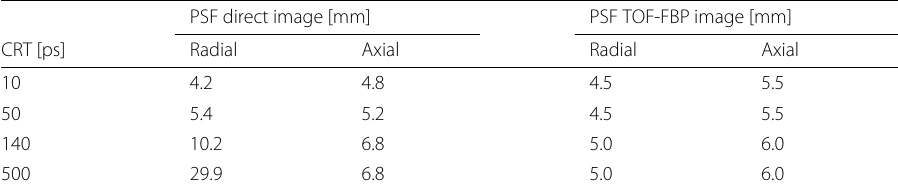
Table 2 Point Spread Function (PSF) obtained for the direct and TOF-FBP images as a function of CRT. Values presented are for position ( x = 20, y = 0, z = 75 ) cm PSF direct image [mm] PSF TOF-FBP image [mm] CRT [ps]